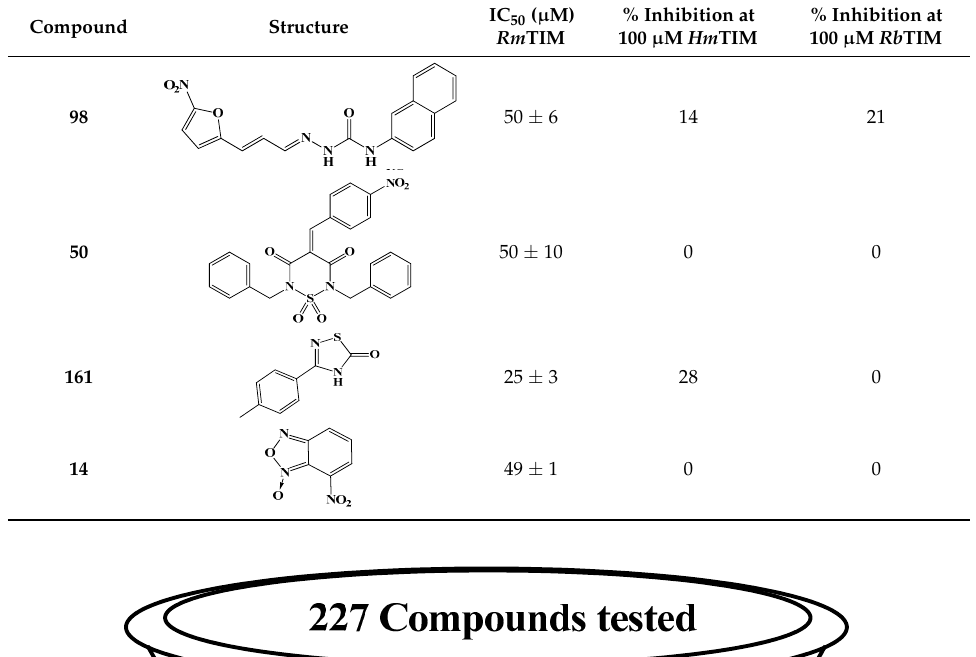
Figure 3. Inhibition results on Rm TIM. Structures of the best Rm TIM inhibitors are identified herein.